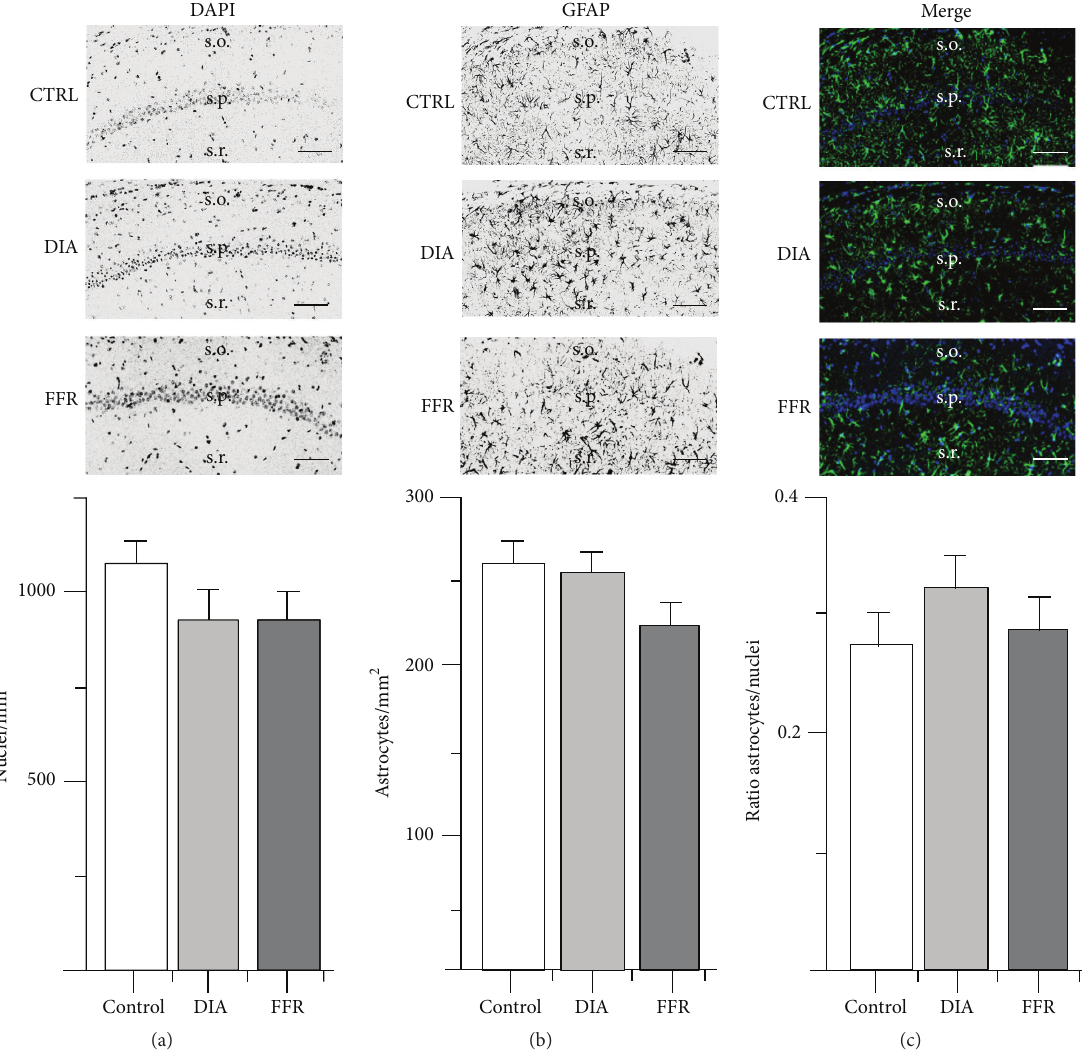
FFRs.p. Control DIA Figure 2: Effect of dehydration-induced anorexia (DIA) on astrocyte density of hippocampal region CA1. Coronal sections of the hippocampus show nuclei labeled with DAPI (a) or immunostained with GFAP (b). The overlay of DAPI and GFAP is shown for control, dehydration-induced anorexia (DIA), and forced food restricted (FFR) experimental groups (c). The densities of nuclei or GFAP+ cells as well as the ratio of astrocyte/nuclei did not differ significantly among experimental groups ( 𝑝 = 0.075 ; 𝑝 = 0.172 ; 𝑝 = 0.417 for the control, DIA, and FFR groups, respectively; see Table 1). Nuclear and astrocyte densities were estimated in the stratum oriens (s.o.) and stratum radiatum (s.r.); stratum pyramidale (s.p.) is indicated as a reference. Scale bar = 50 𝜇 m. Data are mean ± SEM. 2 were observed for astrocyte density between the control ; 𝑛 = 36 ) ( 𝑝 = 0.467 and FFR groups ( 1022 ± 56 nuclei/mm ( 257 ± 14 nuclei/mm 2 ; 𝑛 = 82 ), DIA ( 253 ± 14 nuclei/mm 2 ; 𝑛 = 72 ), and FFR groups ( 221 ± 15 nuclei/mm 2 ; 𝑛 = 66 ) ( 𝑝 = 0.172 ) (Figure 2 and Table 1). We also determined the astrocyte/nuclei ratio by estimating the GFAP+ cells from the total nuclei. The astrocyte/nuclei ratio for the control group was 0.277 ± 0.025 ( 𝑛 = 62 ), and it was not significantly different for the DIA and FFR groups ( 0.324 ± 0.025 ; 𝑛 = 56 and 0.286 ± 0.029 ; 𝑛 = 52 ; 𝑝 = 0.417 ) (Figure 2 and Table 1). nuclei/mm 2 ; 𝑛 = 40 ), DIA ( 1007 ± 51 nuclei/mm 2 ; 𝑛 = 40 ),